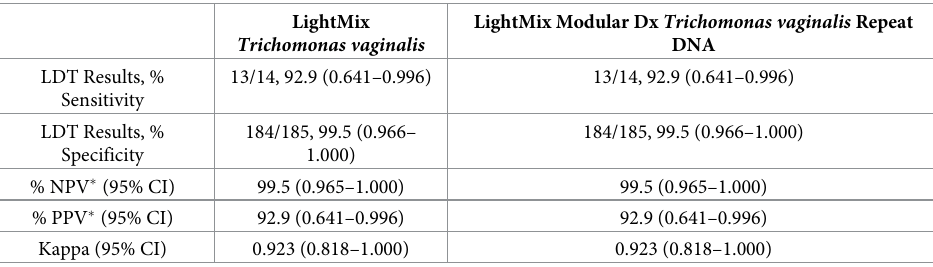
Table 2. Comparative evaluation of the T . vaginalis LDT versus two TIB MOLBIOL NAATs as reference methods ��